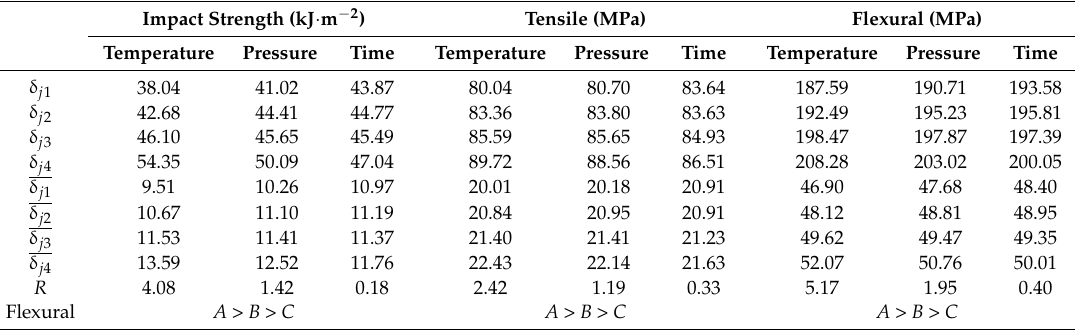
Table 3. Results of the range analysis of the effect of the processing parameters on the mechanical properties of the prepared wood plastic composites